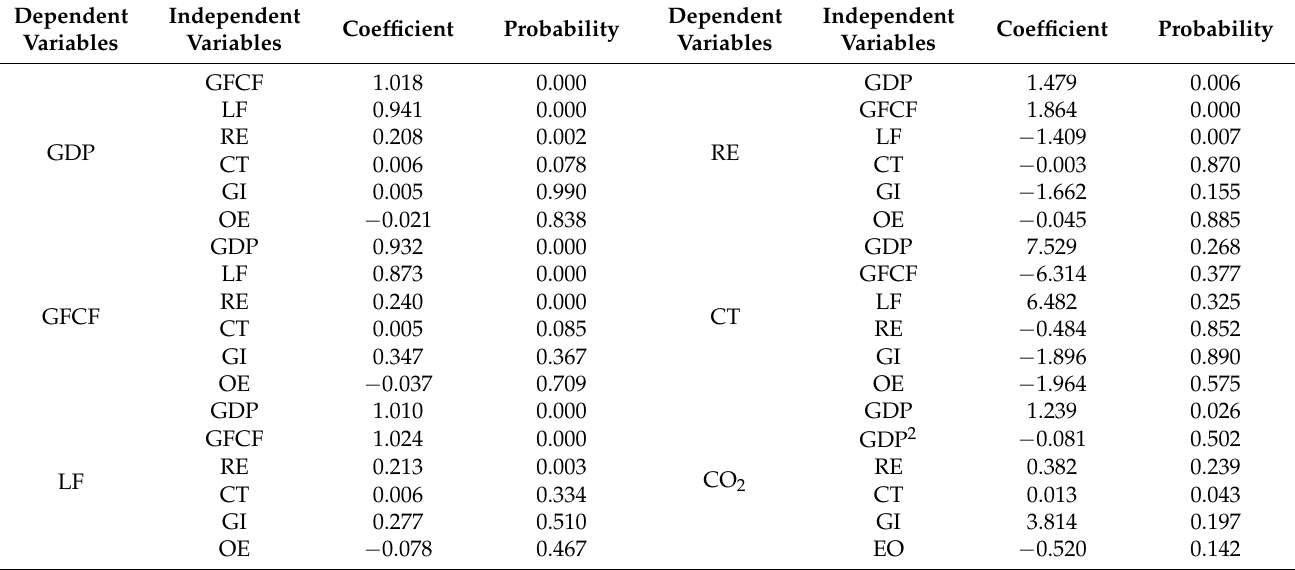
Table 7. The findings of the DOLS panel cointegration